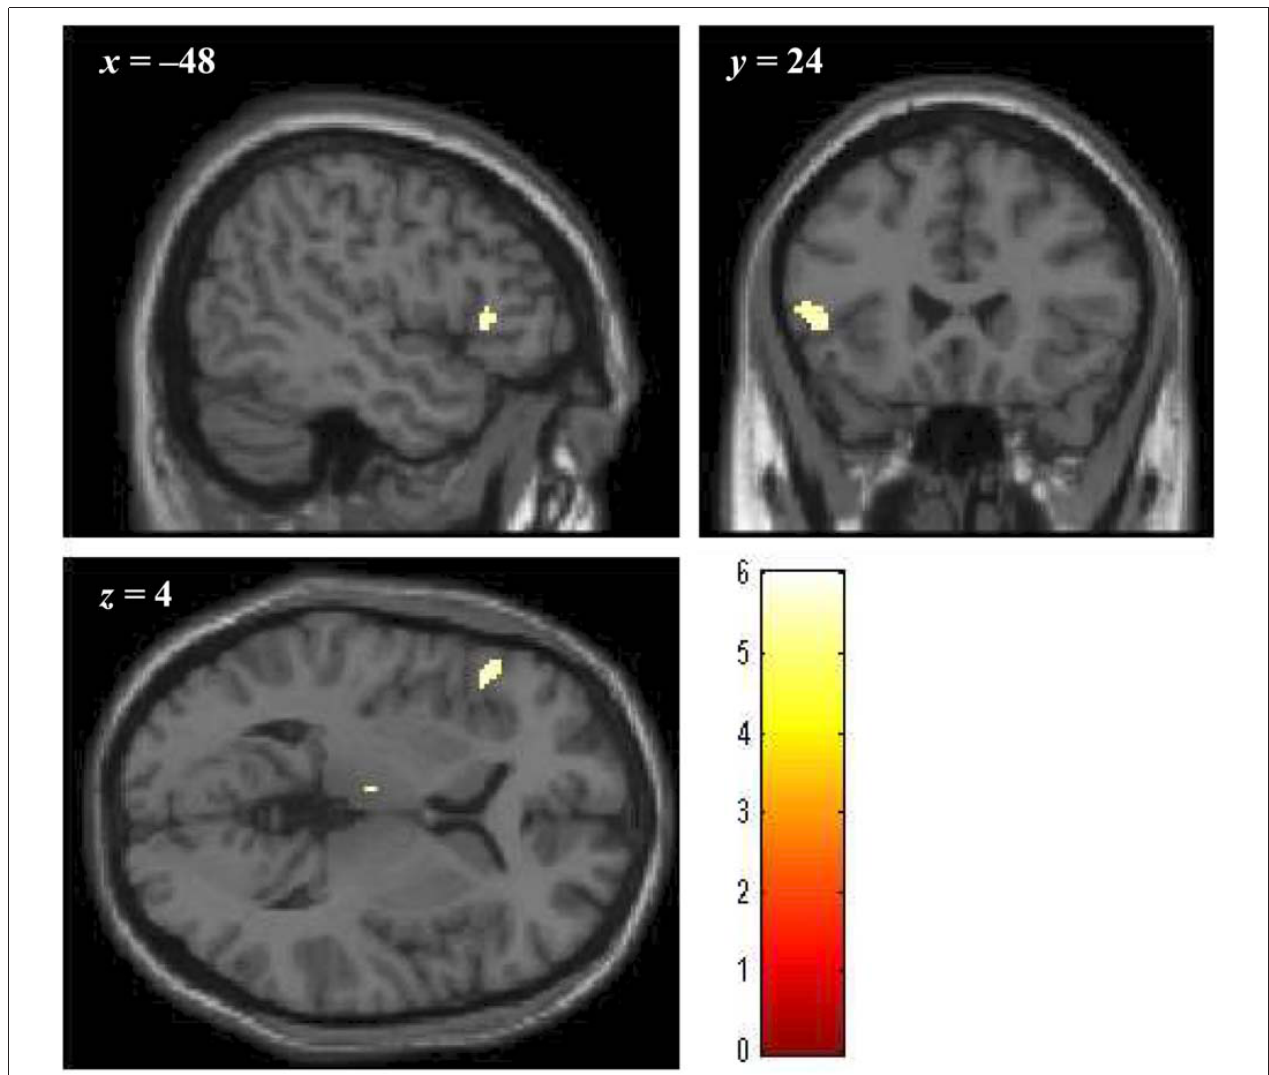
FIGURE 4 | The cluster of voxels in the vlPFC region significantly activated in response to bad reputations during reputation learning ( p < 0.05, FWE corrected at the voxel level; minimum cluster size 20 voxels) . Numbers above slices indicate coordinates in Montréal Neurological Institute (MNI)